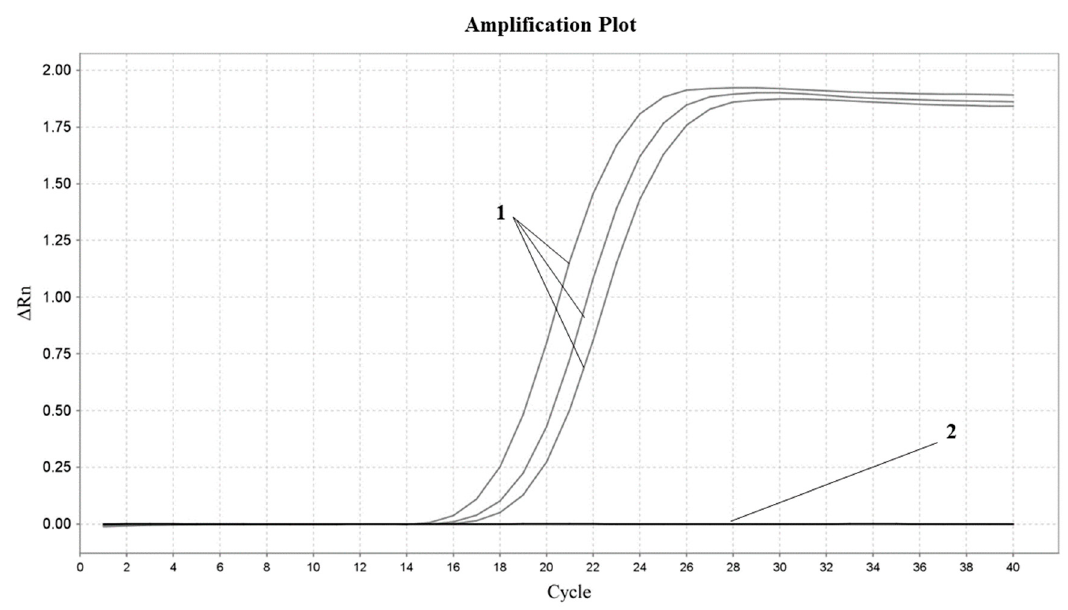
Figure 2. Proofman–LMTIA response specificity assay of ITS gene in soybean. 1: Soybean gDNA; 2: ddH 2 O, sesame, sunflower, walnut, sheep, cattle and others.